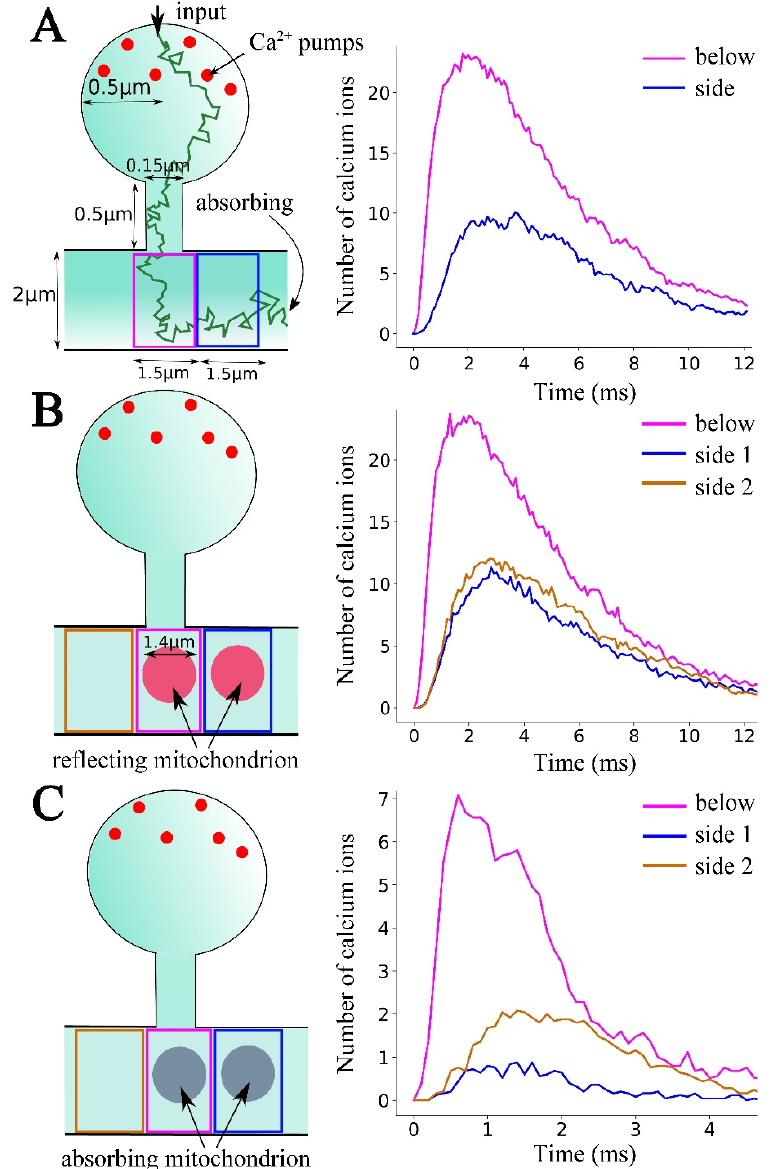
Figure 5. Model. ( A ) Left: Geometry of the spine model. A trajectory (green) of a typical diffusing ion starting from the spine head, until it is absorbed at a side of the dendrite. The squares represent the two cylindrical sections in which the number of calcium ions are counted. Six of the 50 calcium pumps (red) present in the spine head are also shown. Right: calcium dynamics in the dendritic section immediately below the spine (purple) and in the section next to it (magenta). ( B,C ) Left: Placement of spherical obstacles (700 nm radius), with one underneath the spine neck and the other one next to it. Each time calcium ions hit the partially absorbing obstacle ( C ), they disappear with a probability of 0.1. After the remaining 90% of the hits, the ions are reflected back to the medium. Right: Time-courses of calcium in the three areas shown in the Left panels, now under the presence of the obstacles. (Color code of beige, beige and blue also corresponds to the regions in ( A )). All numbers of calcium ions are the averages over 25 trials.